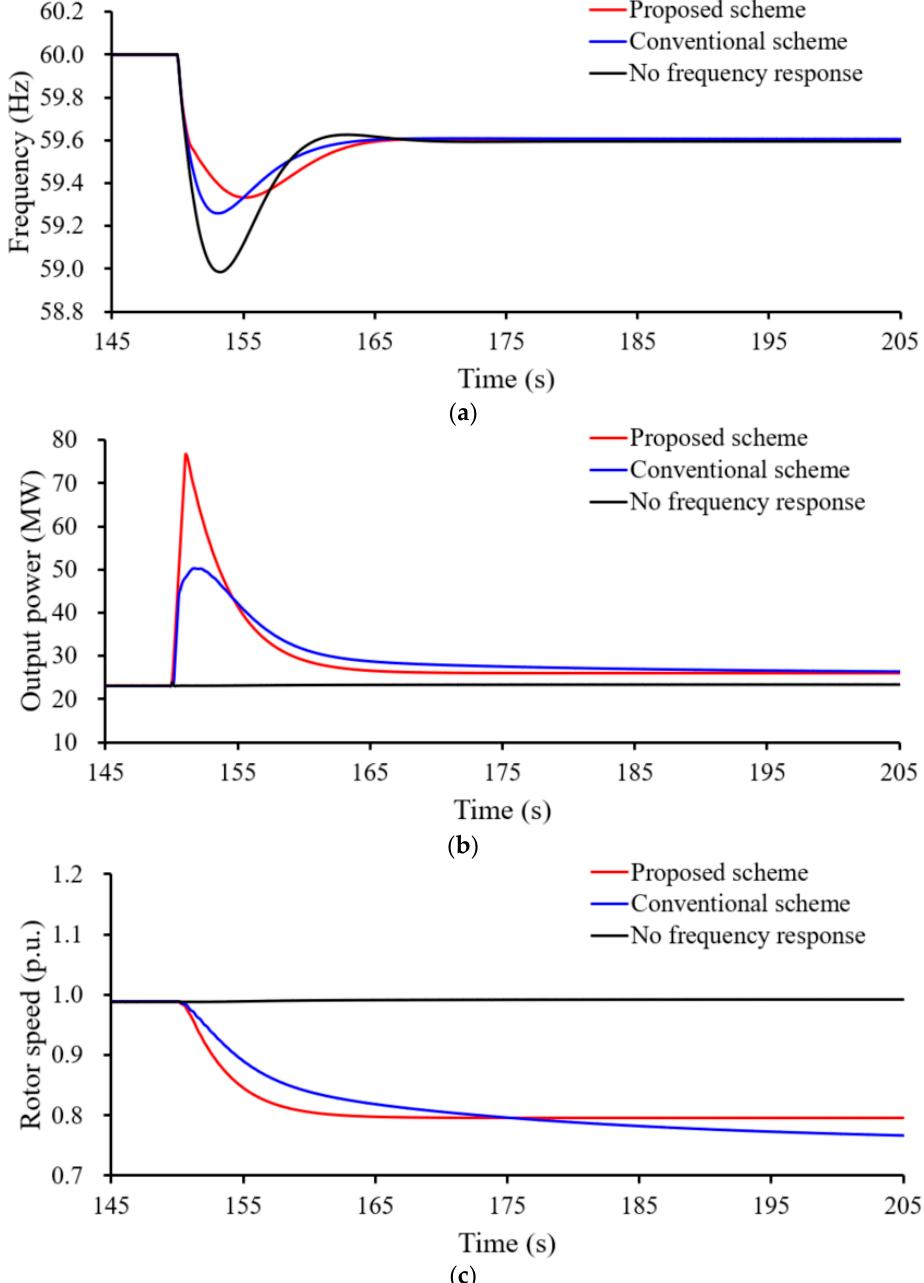
Figure 13. Results for Case 3: ( a ) Frequency; ( b ) Active power; ( c ) Rotor